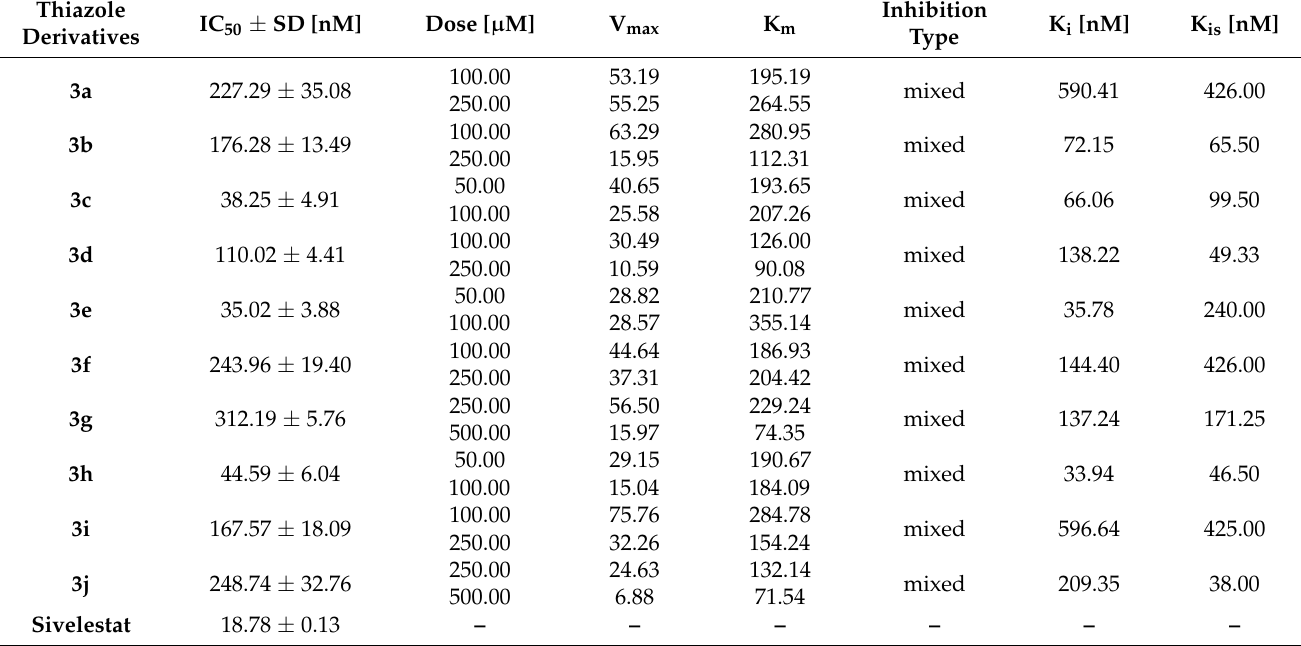
Table 1. Human neutrophil elastase inhibitory activity of 3,3-diethylazetidine-2,4-dione based thia- zoles 3a – 3j and kinetic analysis of their mechanism of